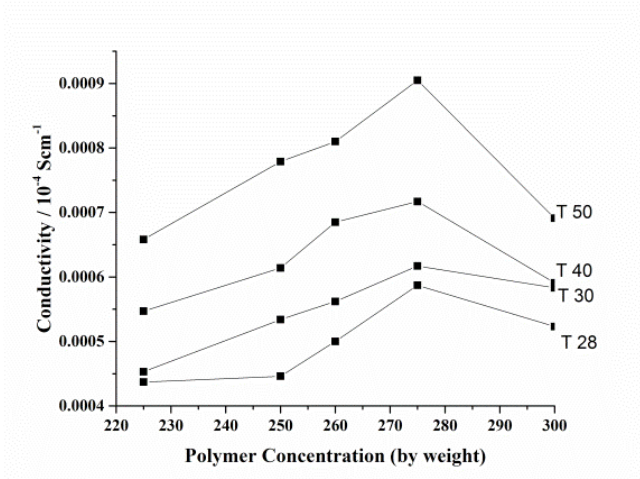
: EC : PC at different temperatures. 2